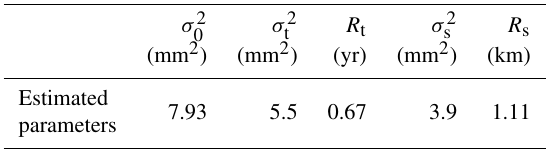
Figure 6. Reduced InSAR timeseries over the Groningen area, with spatial averaging over grids of 5 × 5km and temporal averaging over 6 month intervals, and the structure of the covariance matrix (upper right). Blue areas show the non-zero elements, which are an indica- tion of both spatial and temporal correlation in the